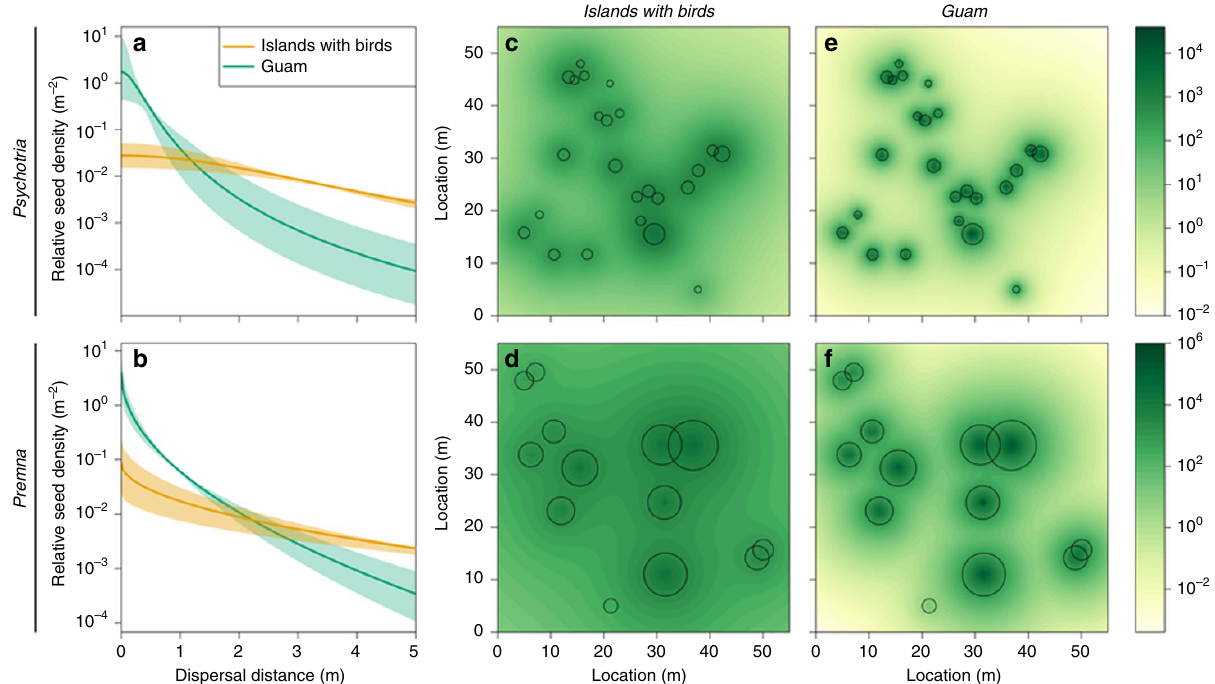
Figure 3 | Dispersal across the landscape. Seed dispersal kernels of ( a ) Psychotria and ( b ) Premna on Guam as compared with three nearby islands where forest birds are present. Curves in a , b show the relative density of seeds arriving at a given distance in any direction from the parent tree, normalized by total fecundity (that is, the integral over all distances and directions is 1). Note logarithmic y -axis scale. Lines are posterior means and shaded regions are 95% credible intervals for the best-supported kernel (2D t for Psychotria ; power-exponential for Premna ) estimated using hierarchical Bayesian methods. The fitted kernel models were used to predict seed rain in a hypothetical forest plot, with tree locations and sizes based on one arbitrarily selected study site. Panels c , d depict seed rain in forests with frugivores, and panes e , f depict seed rain in forests without frugivores. Shading indicates the mean posterior predictive seed density (seeds m (cid:2) 2 , note logarithmic scale) arriving at each location on the forest floor. Circles indicate crowns of conspecific adult trees (drawn to scale from field